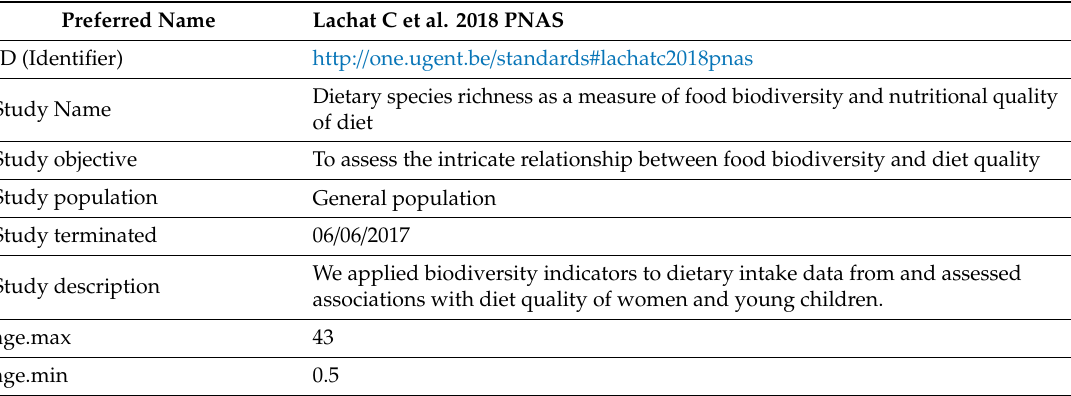
Table A4. Case study: dietary species richness as a measure of food biodiversity and nutritional quality of diet (Lachat et al. 2018), study